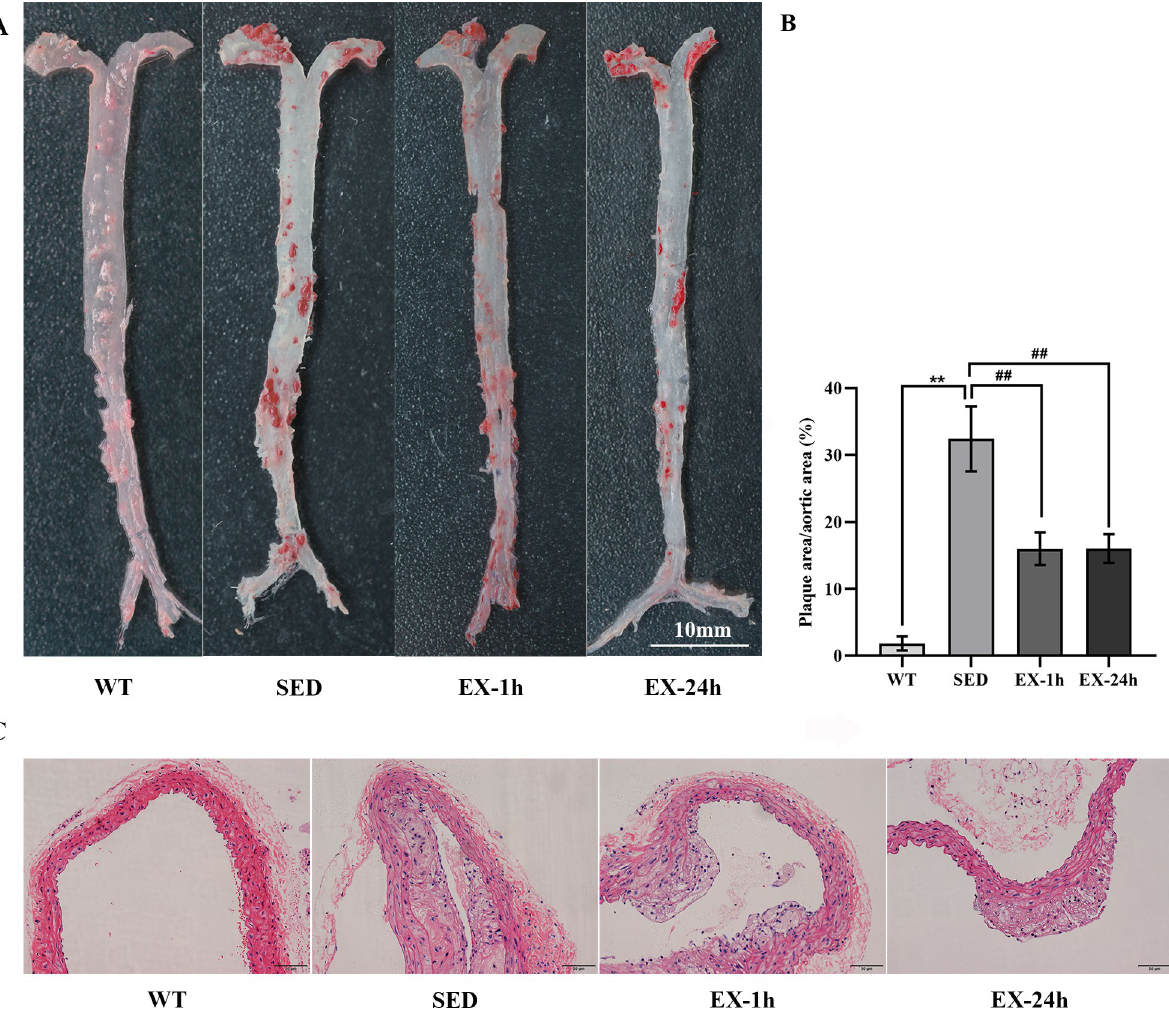
Fig 2. Aerobic exercise inhibits atherosclerosis. ( A ) Representative images of the whole aortic with oil red O staining. Scale bar = 10 mm; ( B ) Comparison of the proportion of aortic plaque area. Data are presented as mean ± SD (n = 5). �� p < 0.01 vs. WT group; ## p < 0.01 vs. SED group. ( C ) Representative images of hematoxylin and eosin (H&E) staining of cross-section of aortic root. Scale bar = 50 μ m.